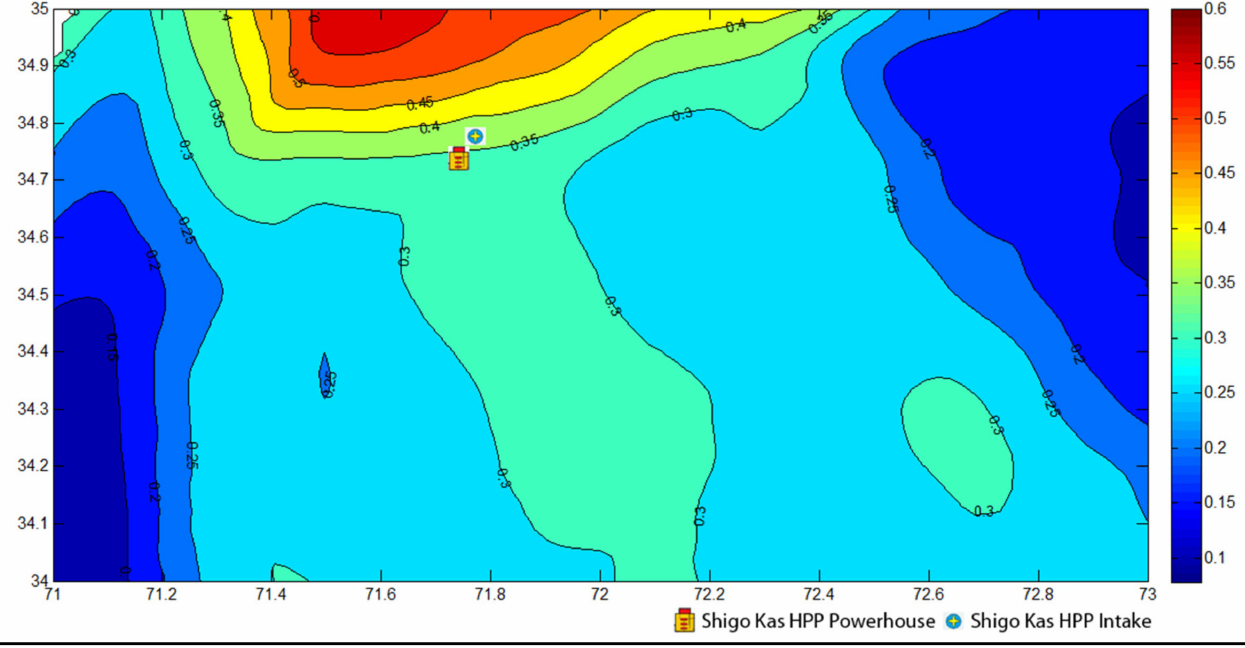
Figure 18. The seismic hazard map of the Shigo Kas HPP area for PGA at a 475-year return period. The legend on the right side of the map shows the PGA in terms of